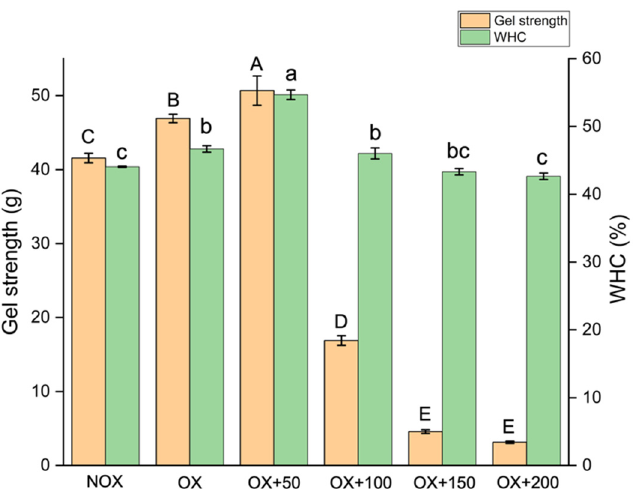
Figure 4. Gel strength and water-holding capacity (WHC) of MP gel treated with various concentra- tions of FOs (0, 50, 100, 150, and 200 µ mol/g protein) under nonoxidizing (NOX) or oxidizing (OX) conditions. Lowercase and uppercase letters represent significant differences in the WHC and gel strength indices between samples ( p < 0.05).